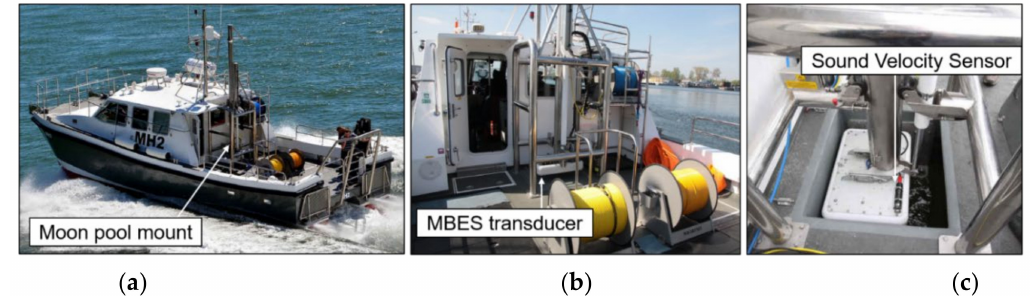
Figure 7. Moon pool installation on board Polish Navy Hydrographic Catamaran MH2, length 12 m. ( a ) Silhouette of Catamaran MH2; ( b ) multibeam echosounder transducer mounted on moon pool; ( c ) sound velocity sensor installed close to